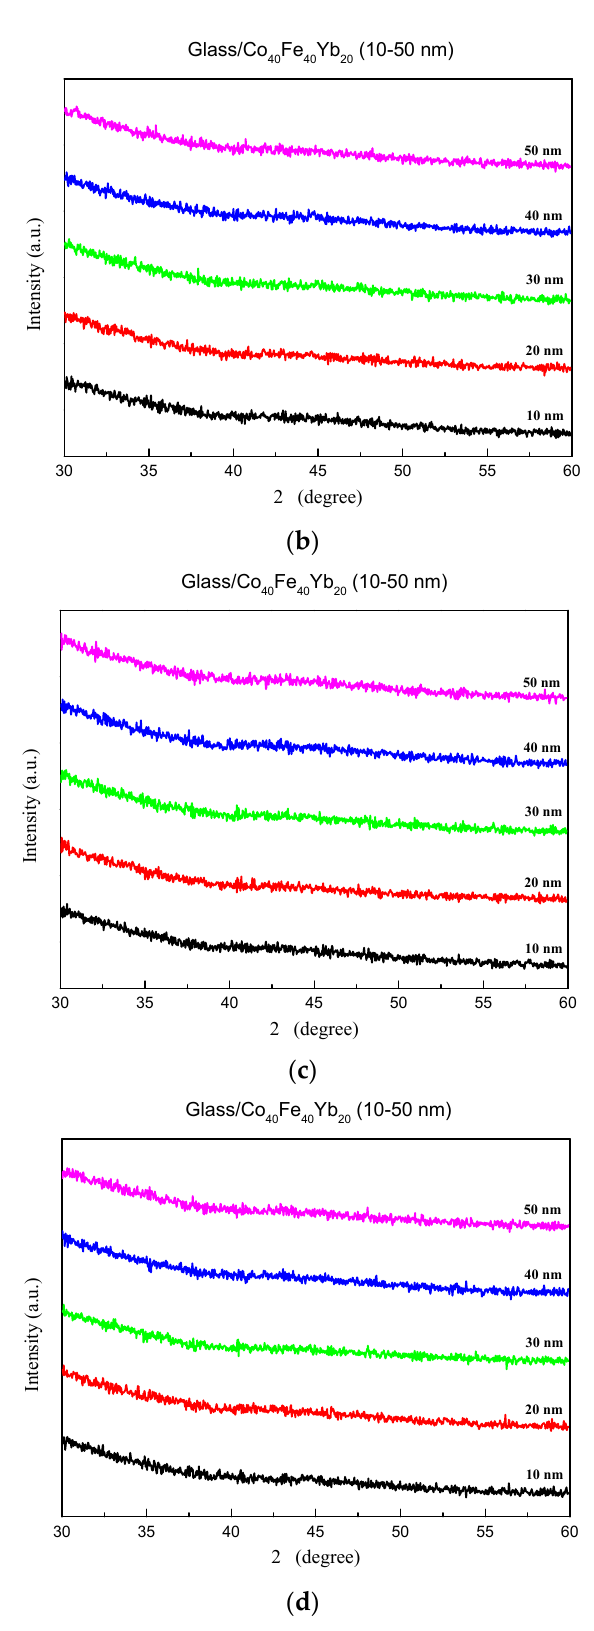
Figure 2. Thin films made of Co 40 Fe 40 Yb 20 with X-ray diffraction patterns. ( a ) as-deposited, ( b ) post-annealing at 100 °C, ( c ) post-annealing at 200 °C, and ( d ) post-annealing at 300 °C.